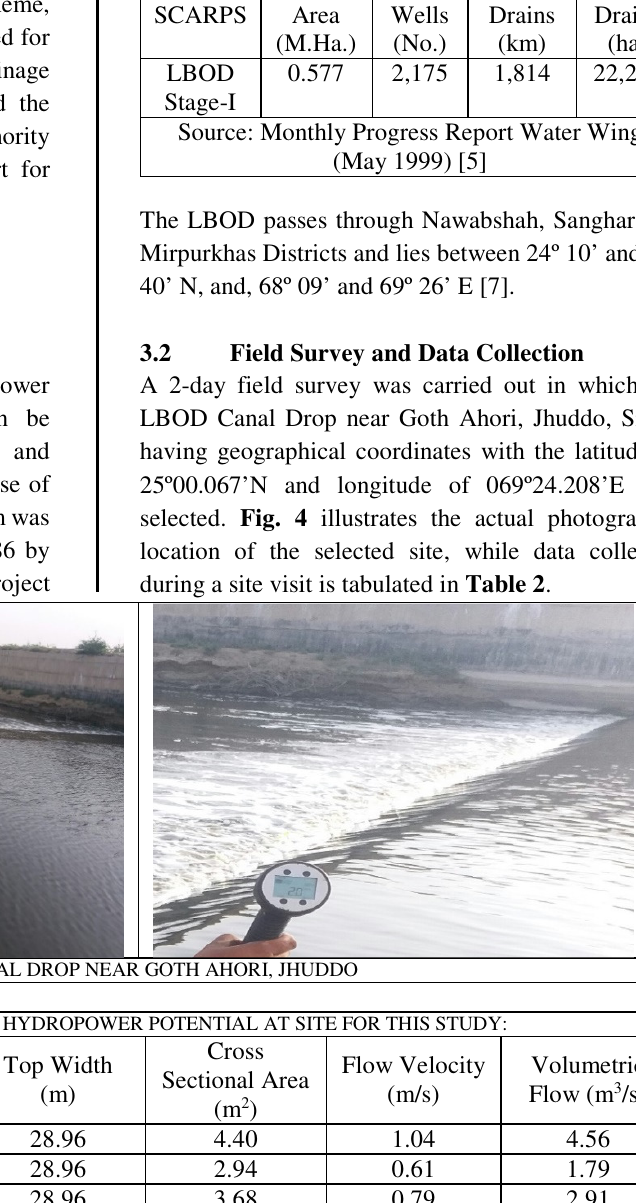
TABLE 1: LBOD STAGE – I DRAINAGE PROJECT DETAILS